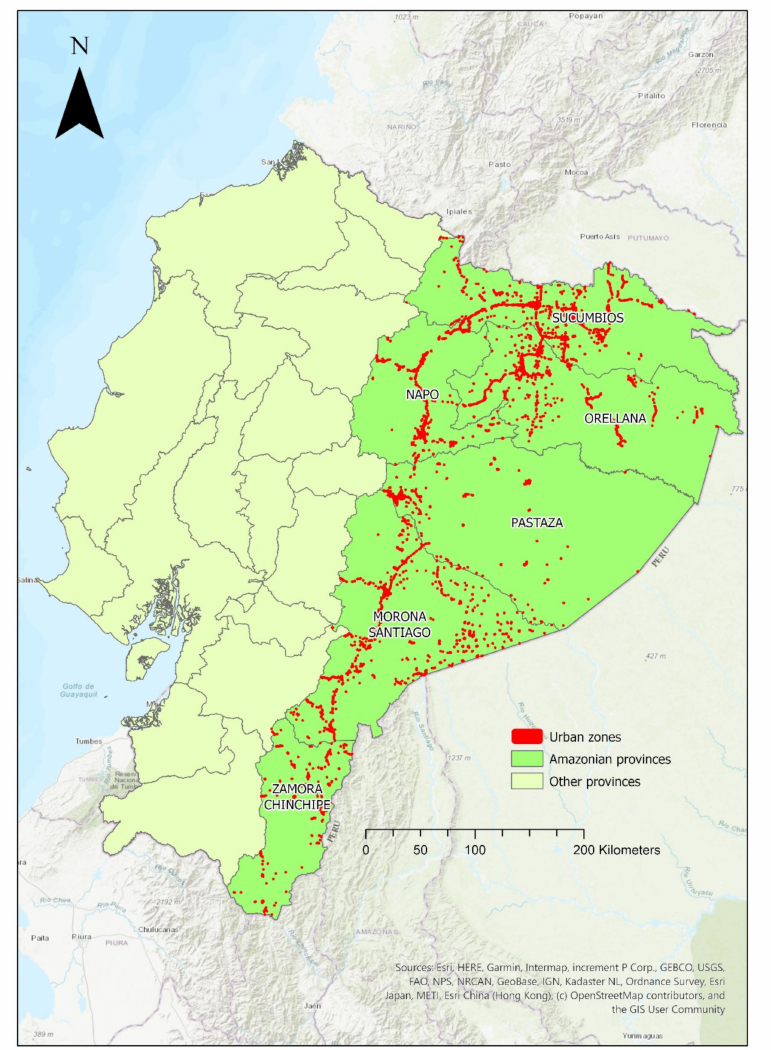
Figure 1. Study area: Provinces and urban zones of the Ecuadorian Amazon. The outline widths of the urban zones are amplified to better visualize their